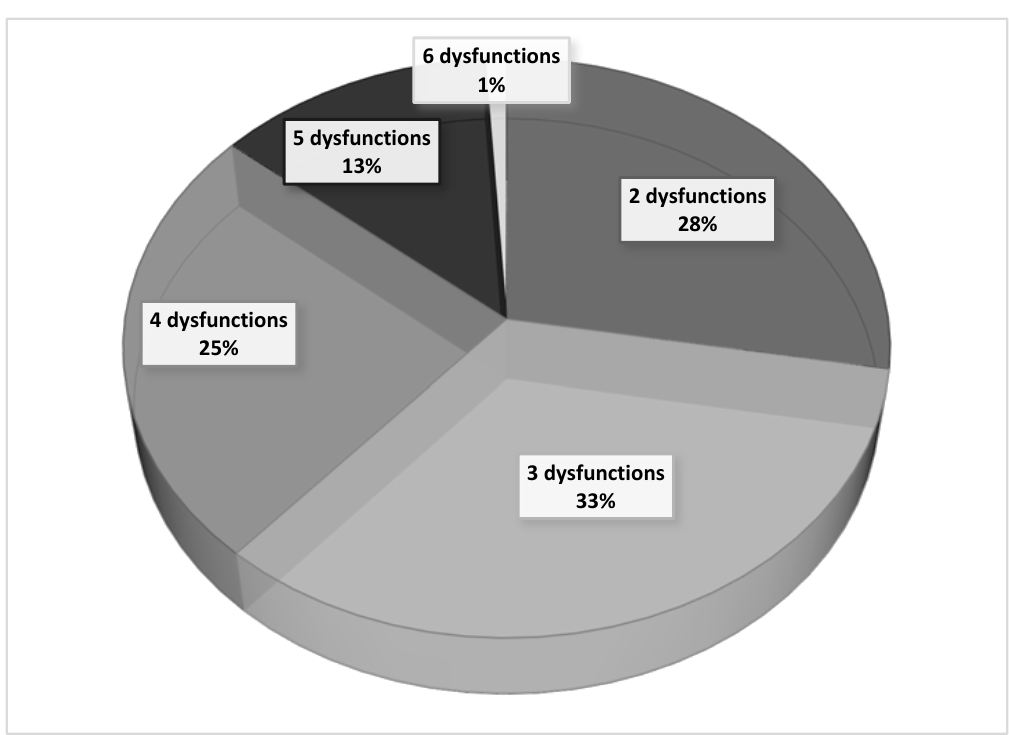
Figure 1. Relative distribution of the number of organ dysfunctions in hospitalized patients with severe malaria.